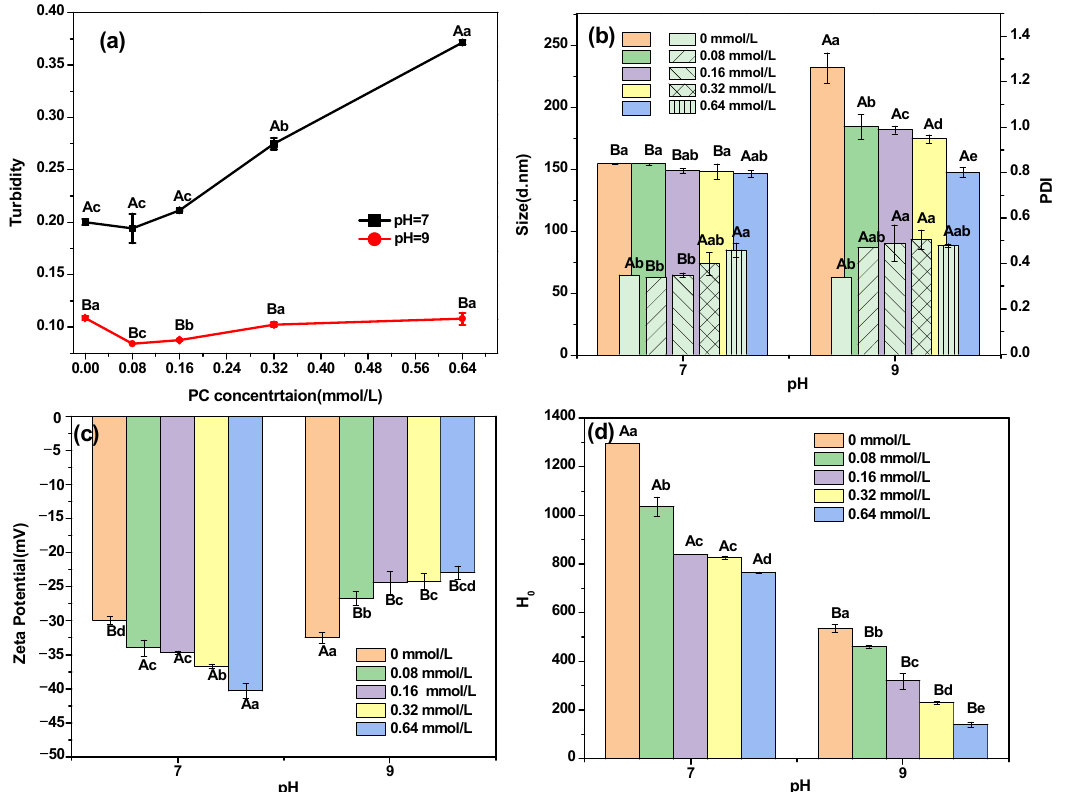
Figure 1. Turbidity ( a ), particle size ( b ), polydispersity index ( b ), zeta potential ( c ), and surface hydrophobicity ( d ) changes of decolorized highland barley protein (DHBP) – proanthocyanidin (PC) complexes formed at pH 7 and 9. a – e mean values under the same conditions with different letters, A,B mean values under different conditions with different letters, indicating significant differences ( p < 0.05), respectively.